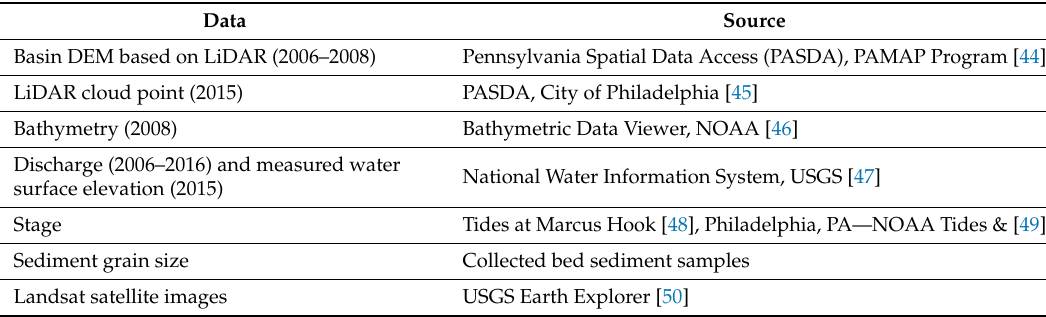
Table 1. Required data for this study included LiDAR, sediment size, stage, and discharge data, as well as satellite imagery.